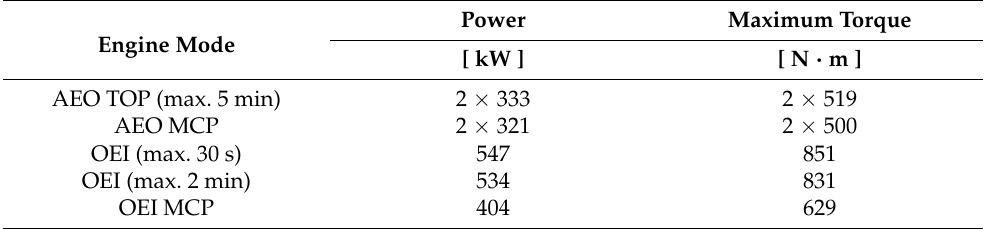
Table 3. Values are taken from [25], pages 8 and 12. The helicopter state AEO denotes ‘all engine operative’, whereas the state OEI stands for ‘one engine inoperative’. Typically, two possible working mode could be selected: TOP (take-off power) that has a time-limit constraint, and MCP (maximum continuous